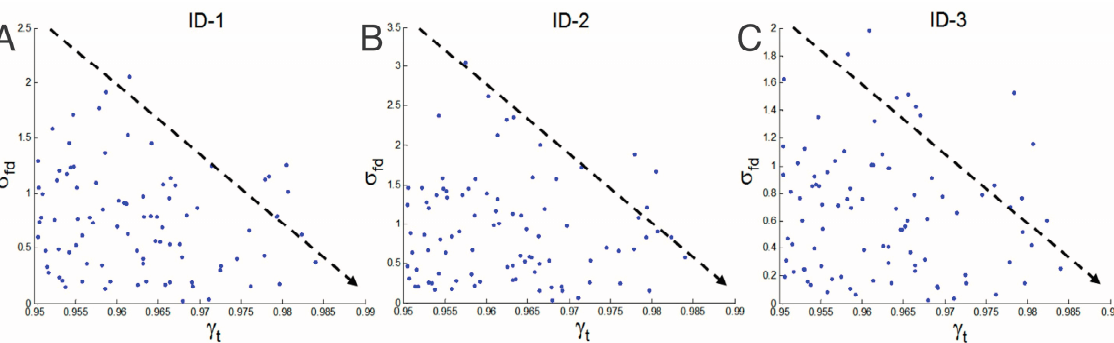
vs. the temporal Φ